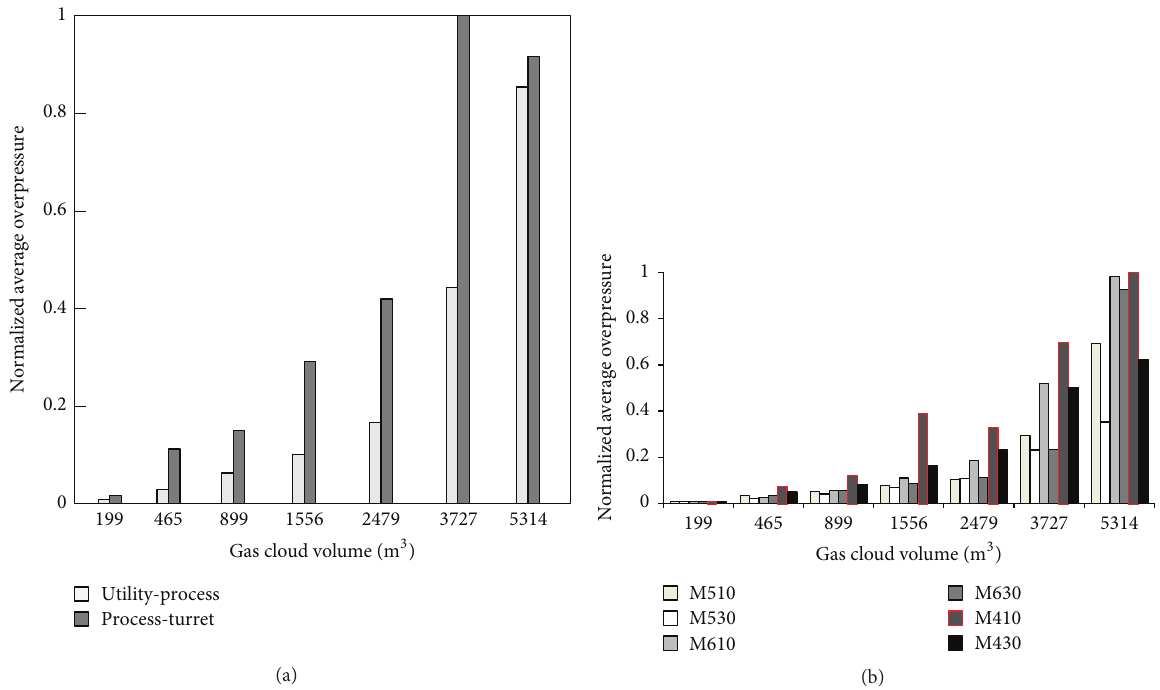
Figure 4: The difference of maximum overpressures according to the gas cloud volume in specific positions. (a) Comparison between utility- process and process-turret area. (b) Comparison at the